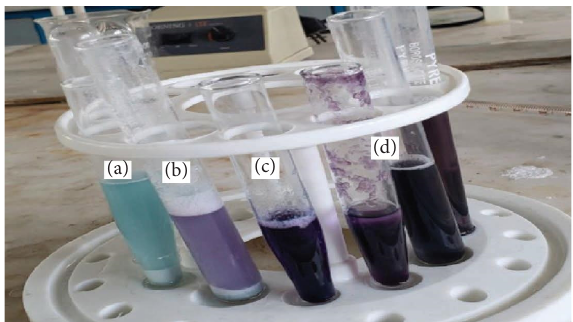
Figure 5: Biuret test method to compare KH with commercial protein fllers (a) fller R, (b) celatan F, (c) bovine serum albumin (BSA), and (d) keratin proteins.